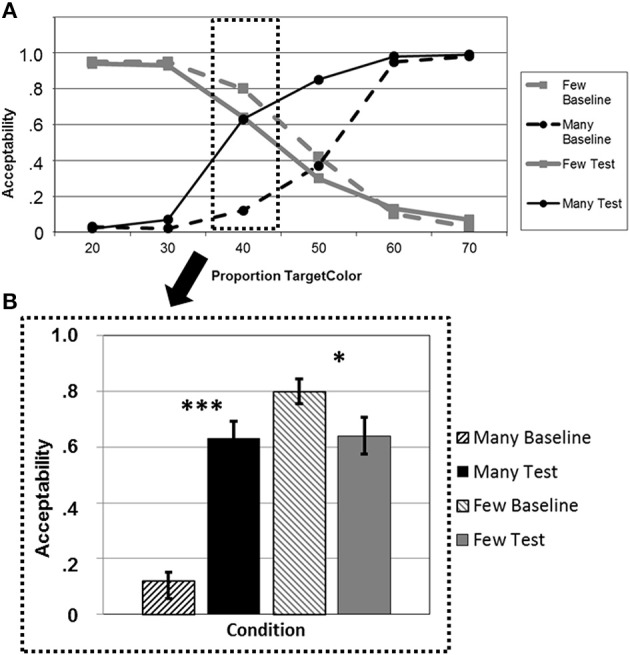
(A). Average acceptability ratings for a given proportion of circles of the mentioned color, plotted separately for the quantifiers “many” (black lines) and “few” (gray lines) in the baseline blocks (dashed lines) and the test blocks after adaptation (solid lines). (B) Average acceptability ratings for a critical proportion of circles of the mentioned color, plotted separately for “many” (black bars) and “few” (gray bars) in the baseline blocks (dashed bars) and the test blocks after adaptation (solid bars). *p < 0.05, ***p < 0.001.